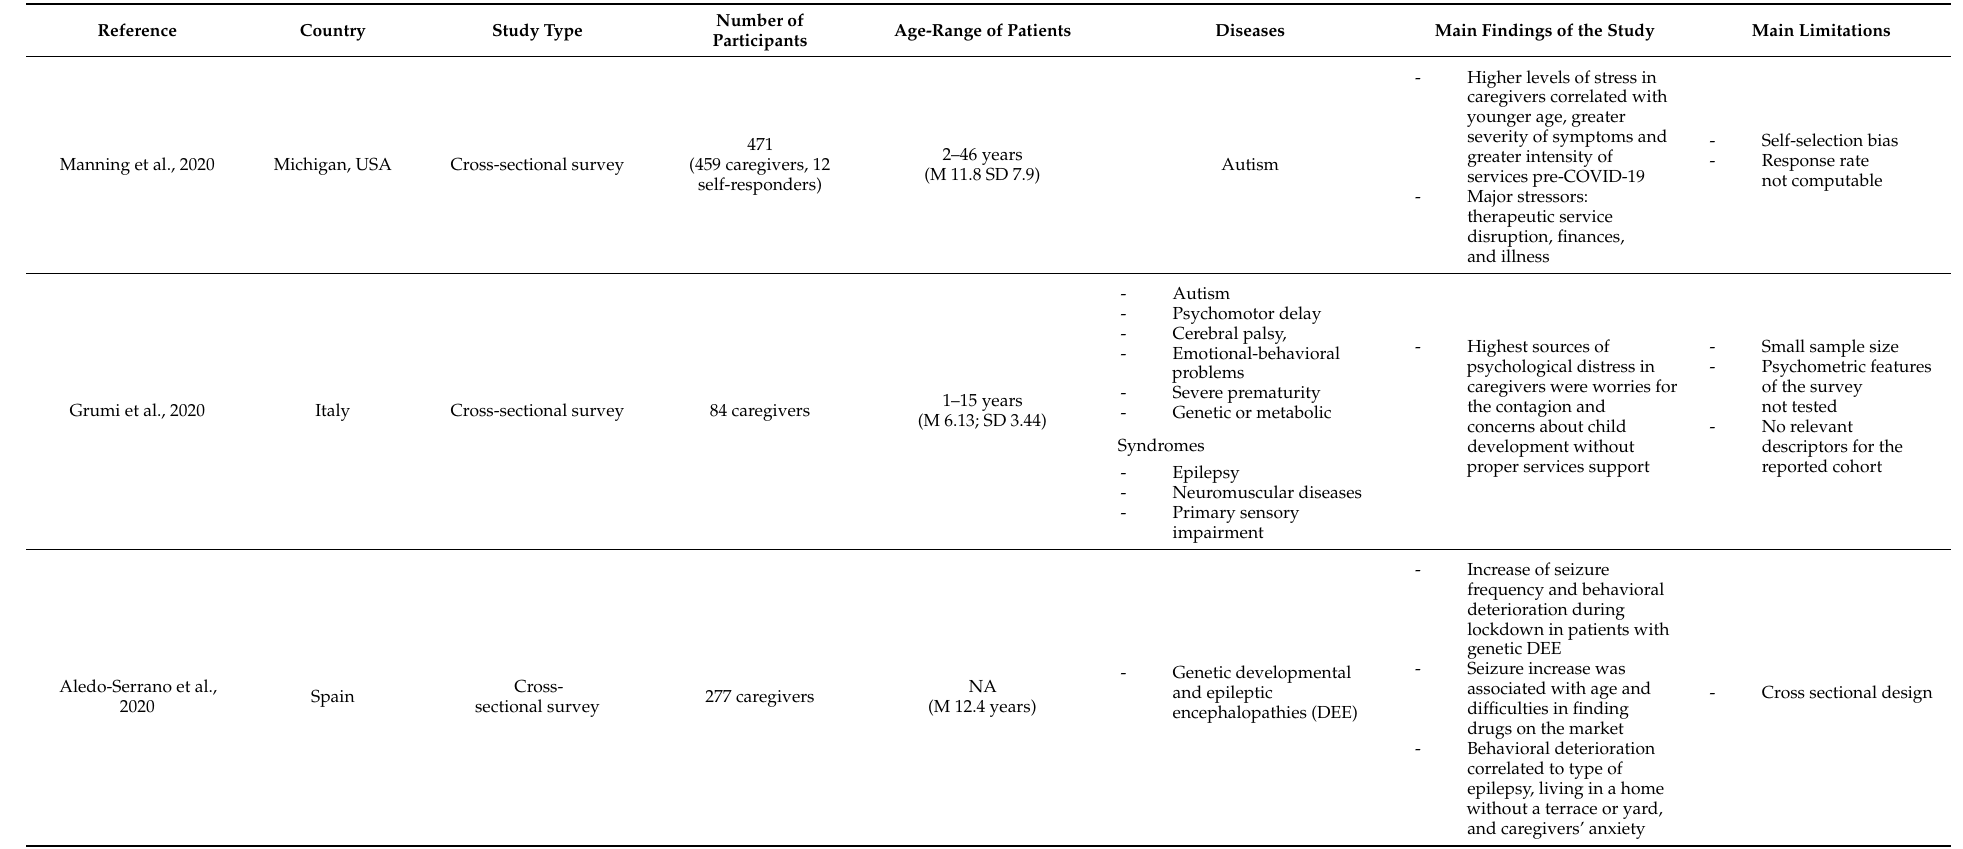
Table 1. The main studies about the health care nodes and caregiver’s stress in children with neurological and neurodevelopmental disorders during the COVID-19